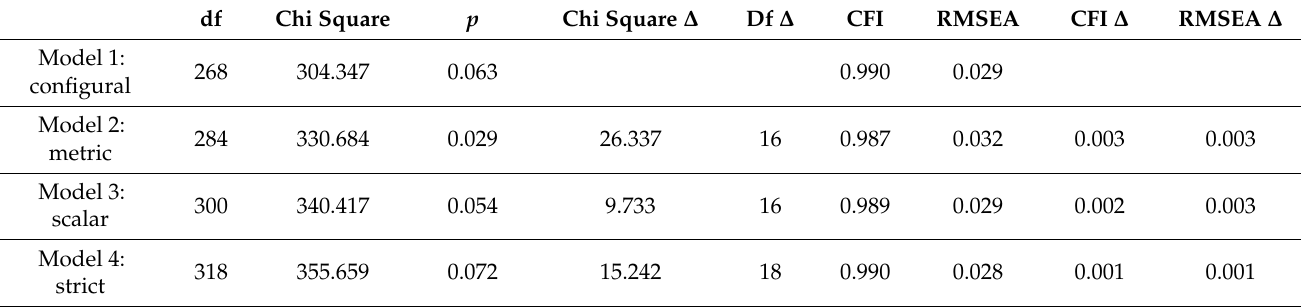
Table 4. Measurement invariance models regarding the two groups (males/females).